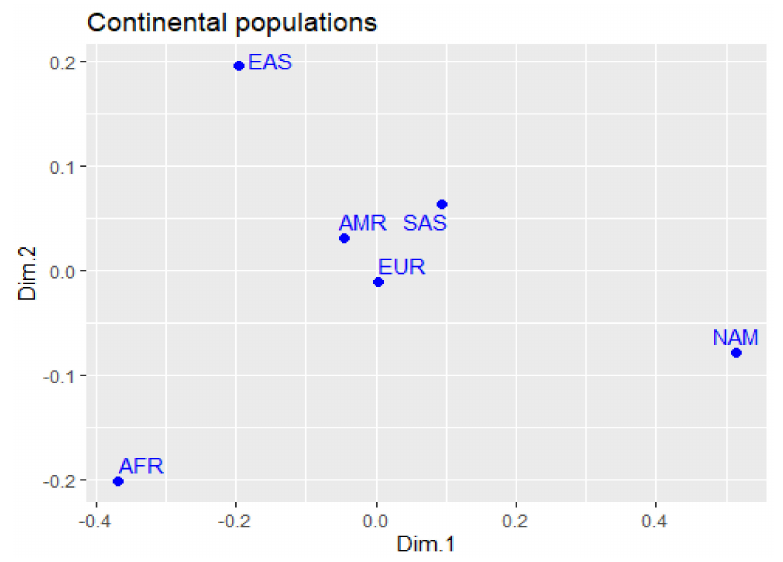
Figure 1. Differences in allele frequencies of the variants studied in the continental populations and the Native American population, plotted in